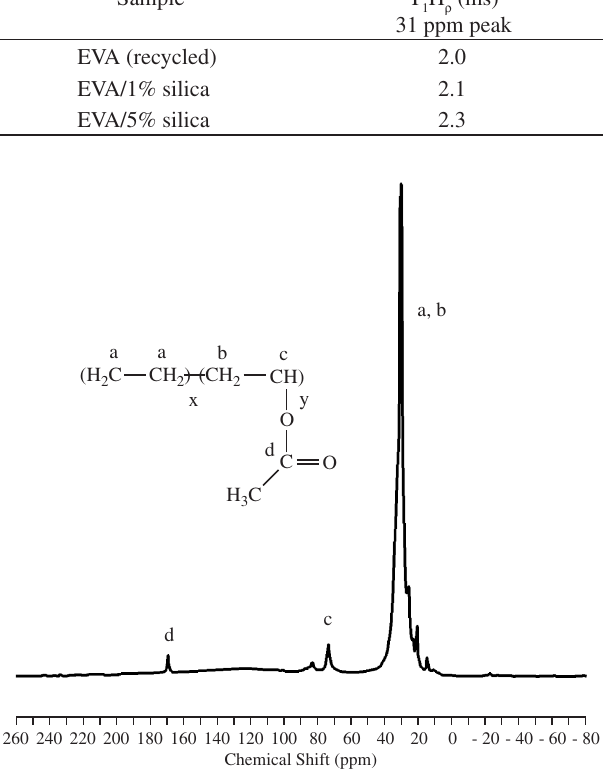
H relaxation data. 1 ρ